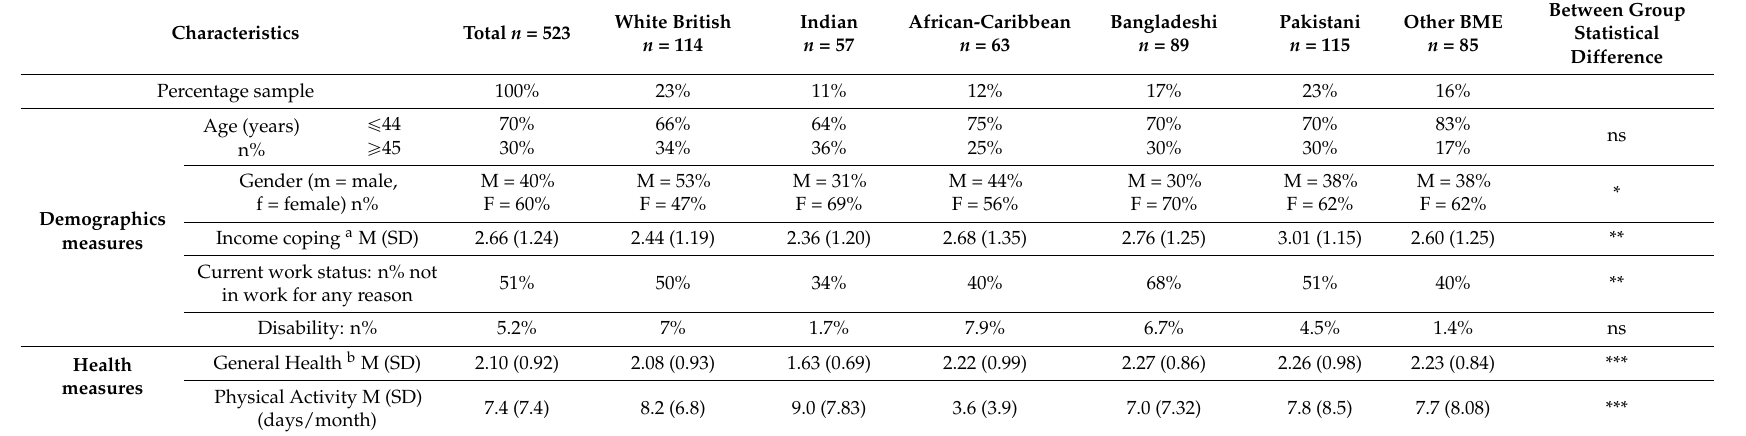
Table 1. Individual characteristics of six ethnic groups, n =